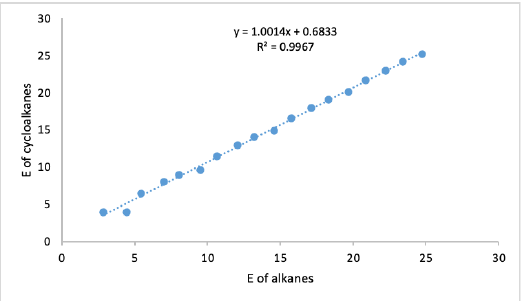
Figure 2. Correlation between graph energy of alkanes and